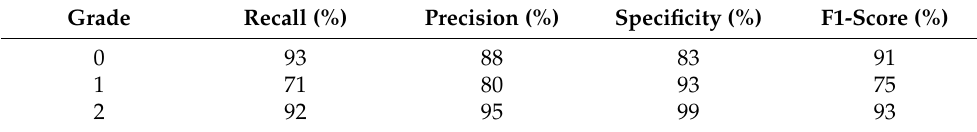
Table 6. Performance of the proposed DHL-II applied to the unseen dataset of three classes.